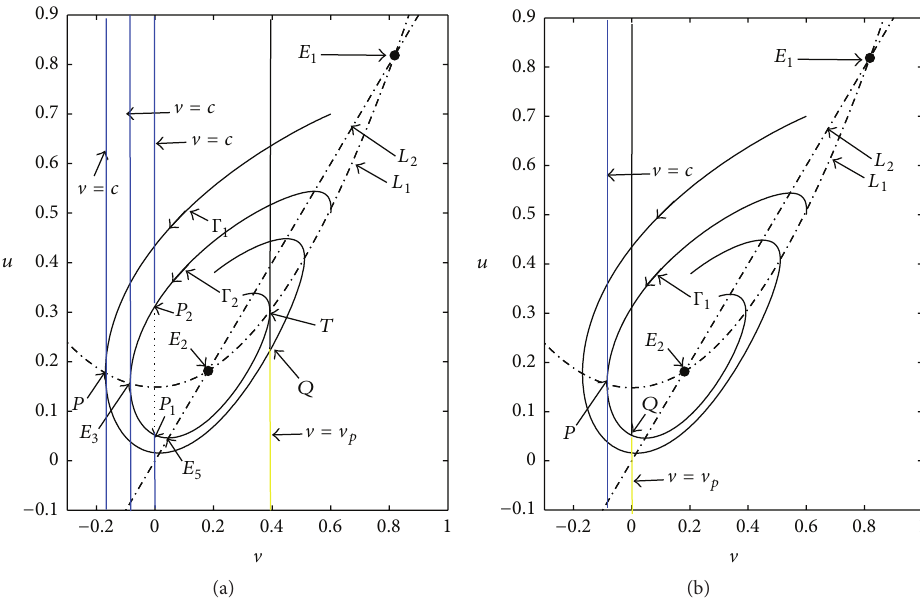
Figure 2: Illustrations of the domains of phase set and impulsive set: (a) for case (𝐴 2 ) ; (b) for case (𝐴 3 ) .